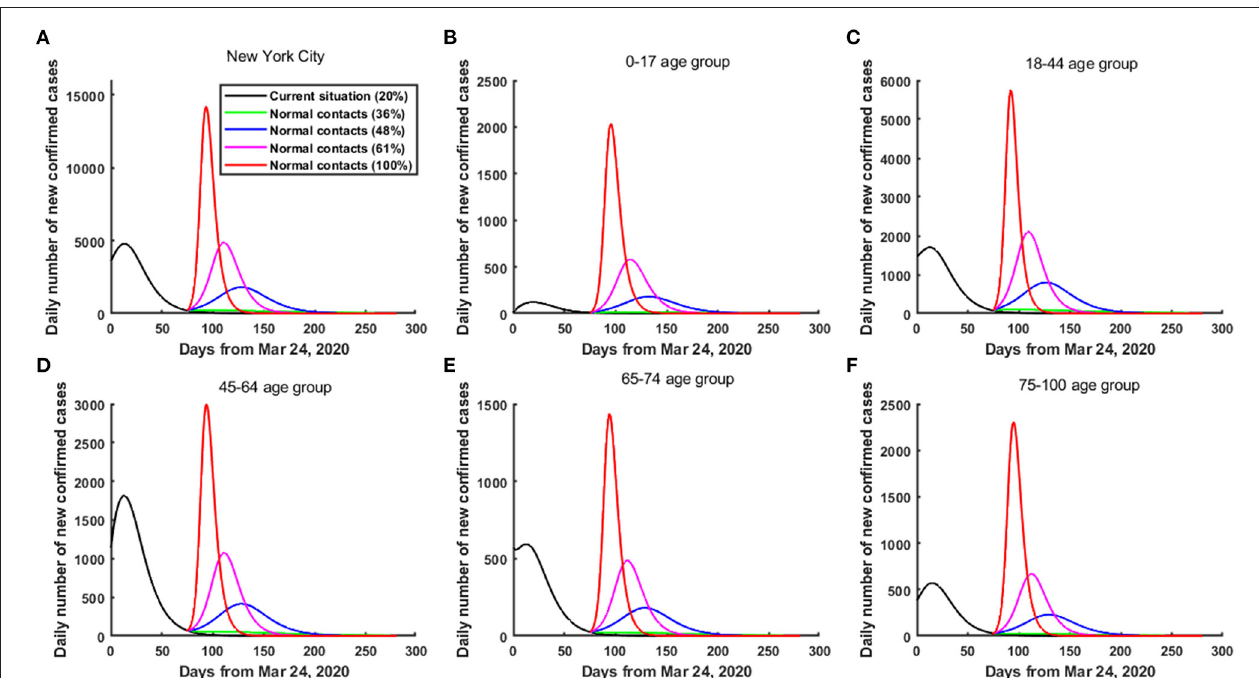
FIGURE 5 | The risk of a second wave of COVID-19 in NYC when only the 0–17 and 18-44 age groups were released from June 8, 2020. (A) In the whole population of NYC. (B) In the 0–17 age group. (C) In the 18–44 age group. (D) In the 45–64 age group. (E) In the 65–74 age group. (F) In the 75–100 age group.